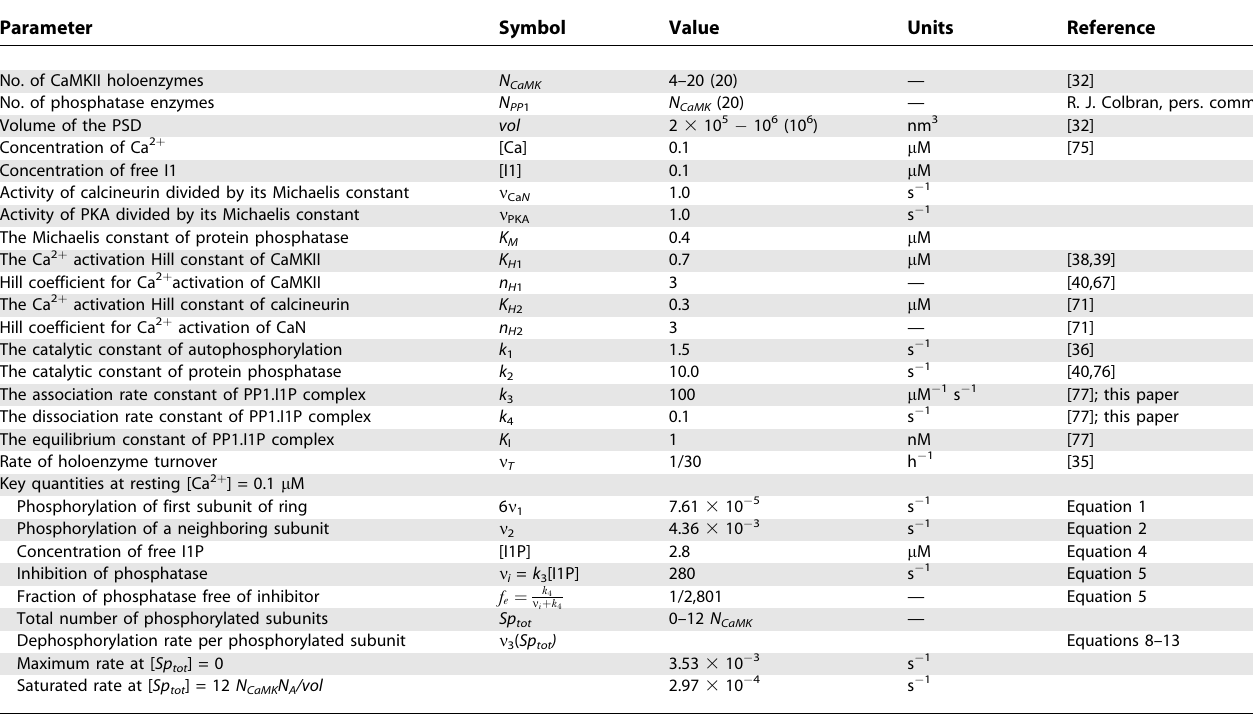
Table 1. Parameters Used in the Model Parameter Symbol